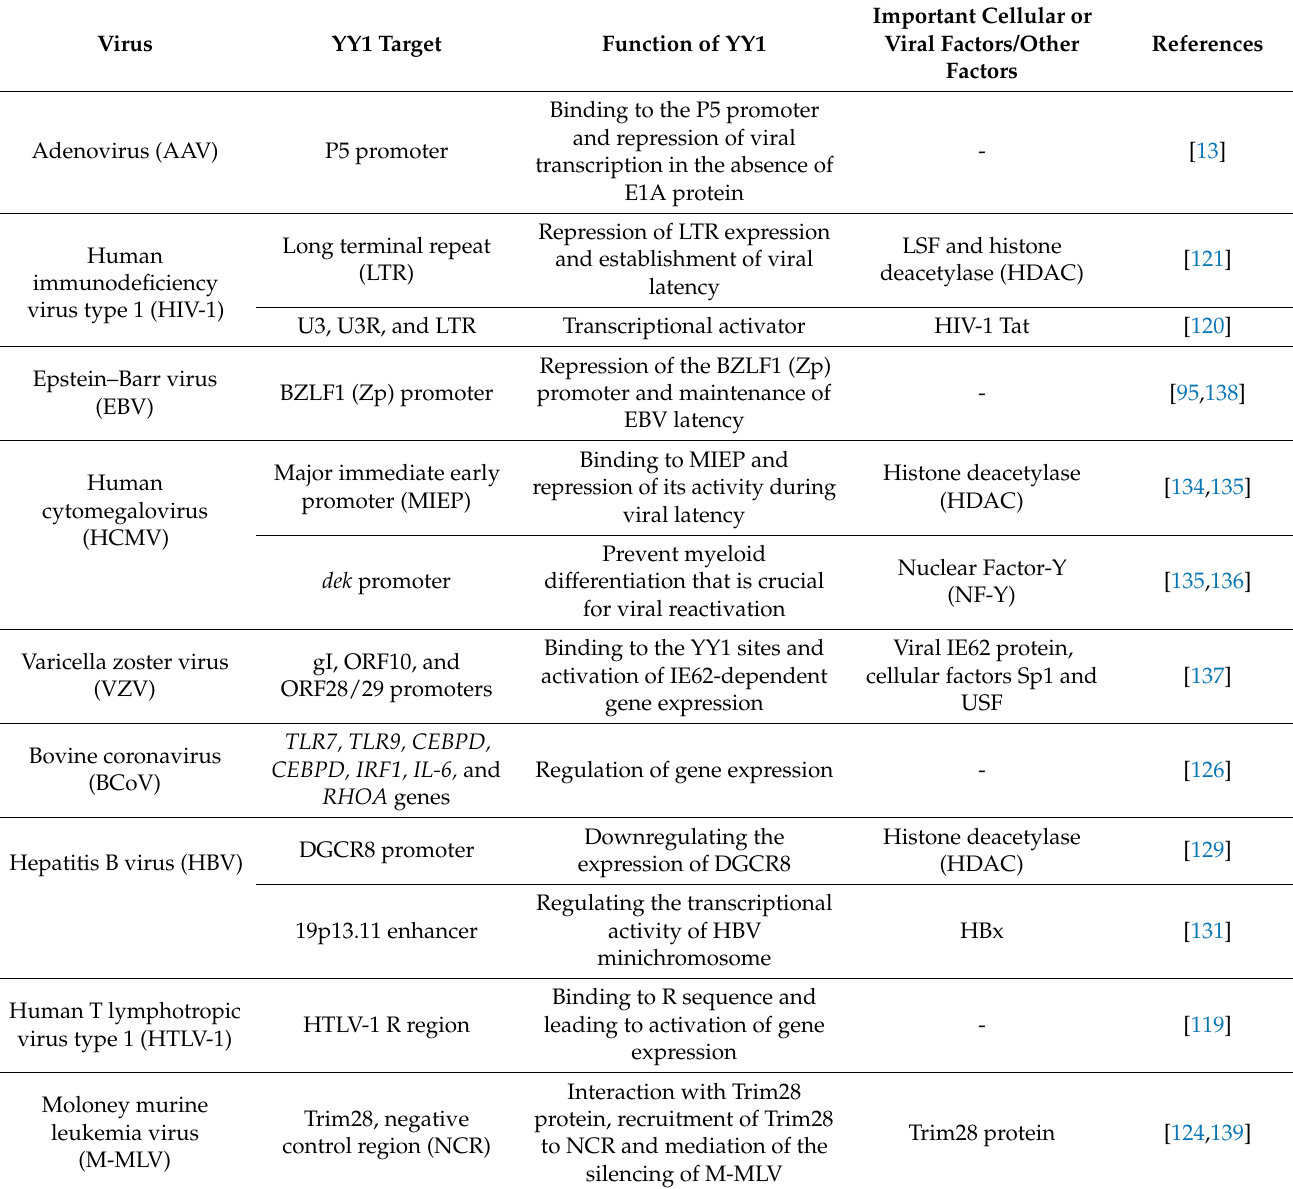
Table 2. Role of YY1 in the life cycle of different